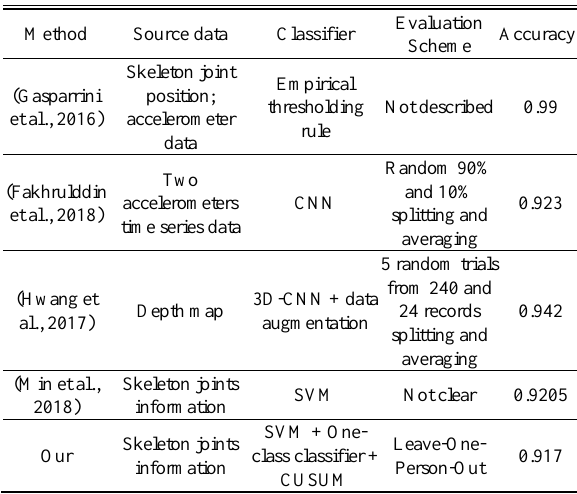
Table 6. The accuracy of fall detection algorithms